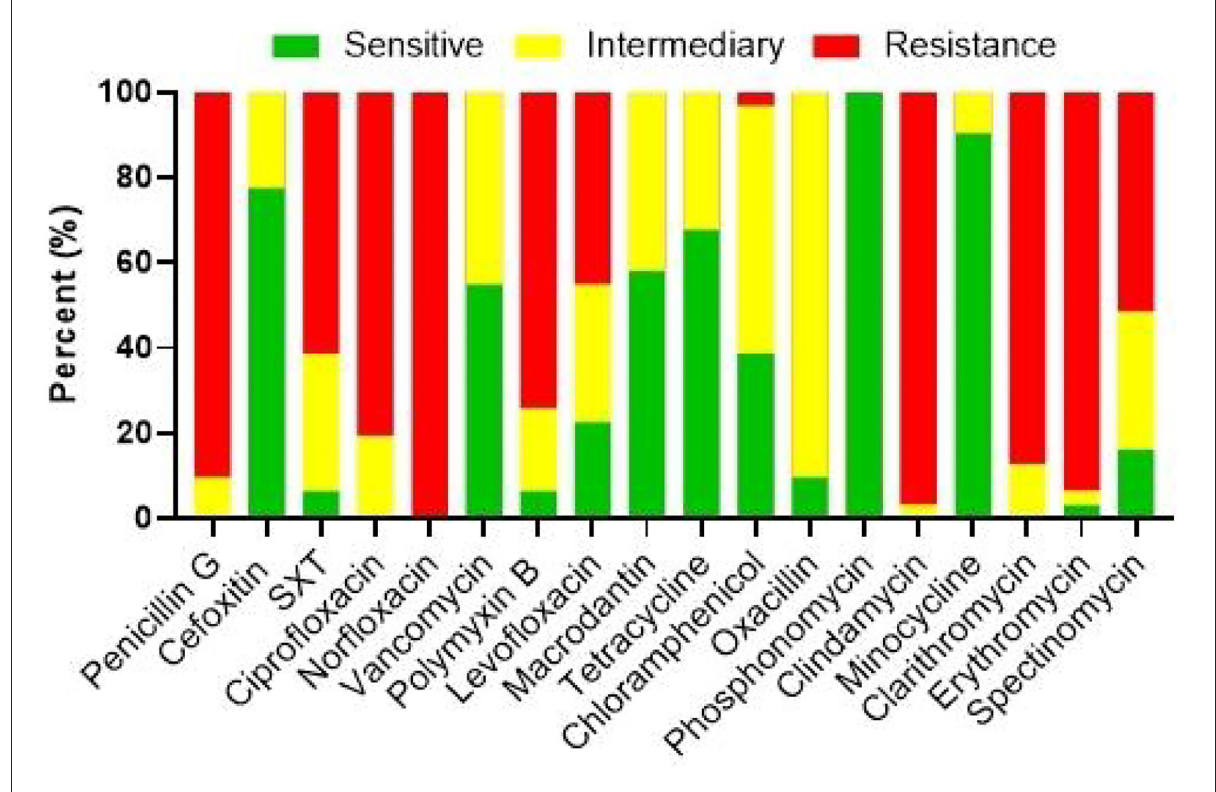
FIGURE3 The antibiotic resistance analysis of S. aureus